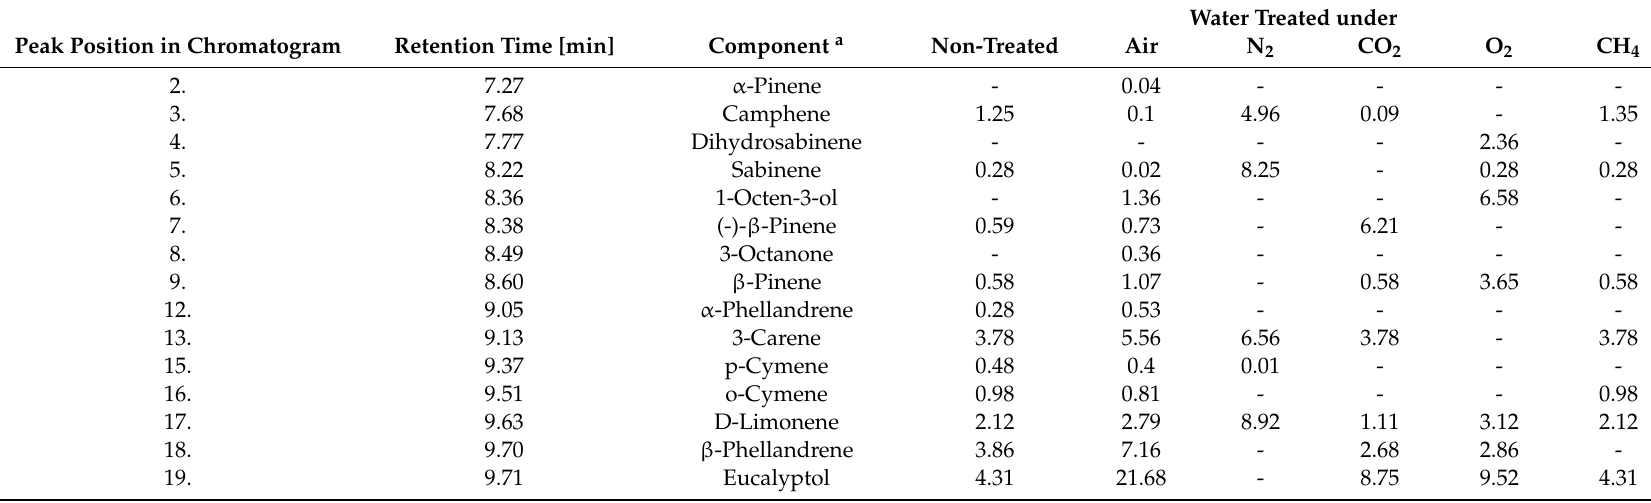
Table 3. Chromatographic characteristics of essential oils isolated from Lavandula angustifolia watered with water treated with glow plasma in contact with the air, oxygen-free nitrogen, carbon dioxide, molecular oxygen and